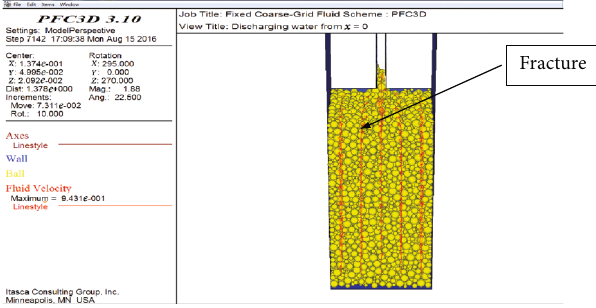
Figure 9: The change of the particle fl ow